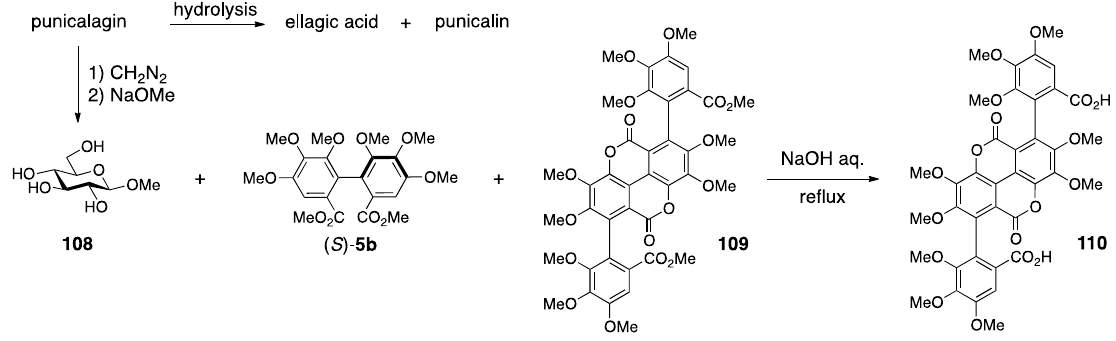
Figure 40. The transition of the structures of punicalin and punicalagin.